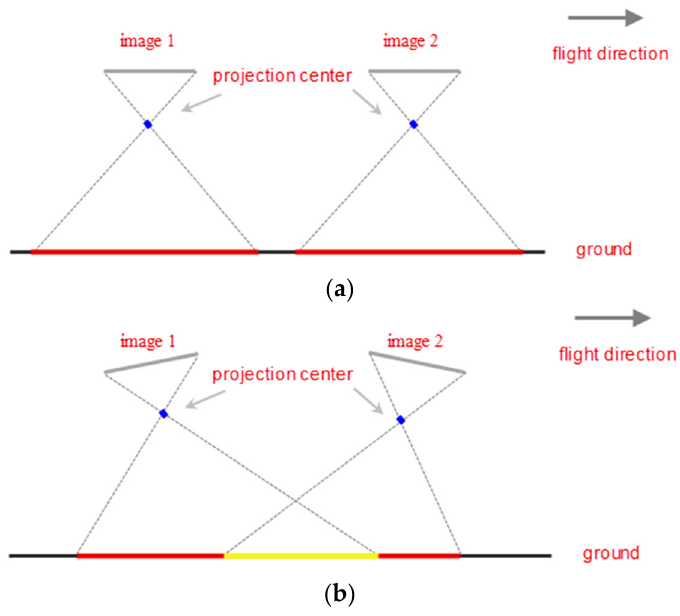
Figure 8. Image pair search: ( a ) only GNSS used for image pair search; and ( b ) combination of GNSS and mounting angles used for image pair search.